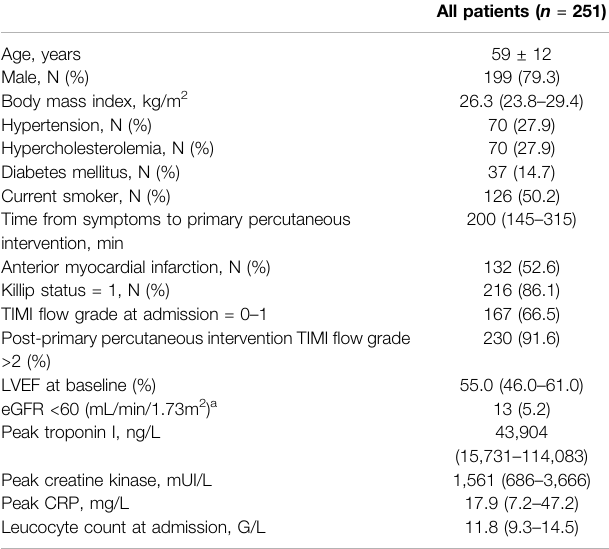
TABLE 1 | Characteristics of the study population.